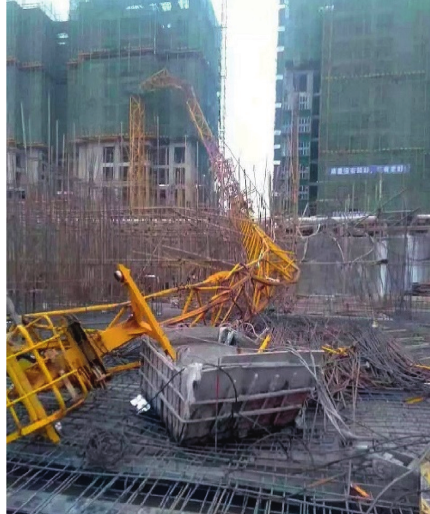
Figure 10: On-site sceneries of Shanxi tower crane accident.